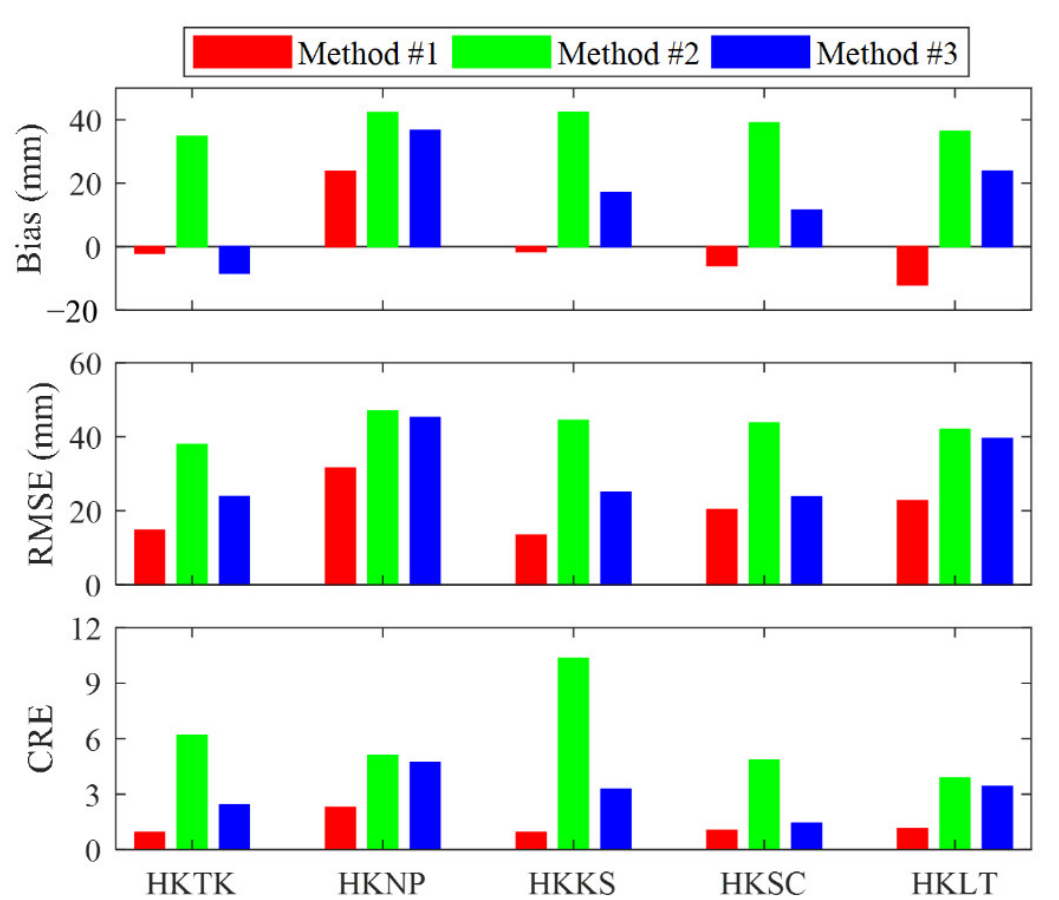
Figure 7. Histogram of bias, RMSE, and CRE at five sites for the three methods. To further illustrate the performance of the three methods in different sites, we counted the residuals between ZTD derived from the three models and the referenced ZTD, which are shown in form of boxplot in Figure 8. Box plots were used to explore the statistical characteristics of ZTD residuals, in which three characteristic values are shown. Q1 and Q3 located at the bottom and top of the box represent the first and third quartiles, respectively. The interquartile range, defined as the difference between Q3 and Q1, reflects the discreteness of a set of data. The second quartile (Q2) was located inside the box, representing the median value. At each site, the length of the box and the range of bound in Method #1 (in red) were smaller than those of other two methods (in blue and green), indicating better residual distribution using the proposed model. In this verification, Method #1 had best performance, with the median of residuals being −0.6, 29.5, 2.2, 1.2, and −3.3 mm, and 50% of the residuals were concentrated in the range of −7.2 to 7.5, 15.4 to 35.0, −5.4 to 5.7, −8.8 to 6.6, and −22.6 to 1.0 mm for HKTK, HKNP, HKKS, HKSC, and HKLT, respectively.